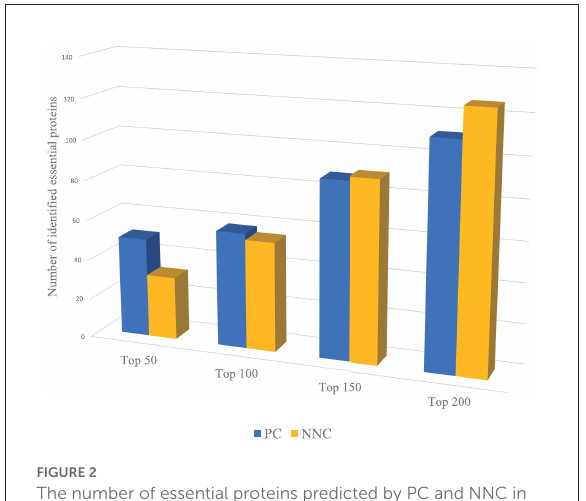
FIGURE2 The number of essential proteins predicted by PC and NNC in different scales.